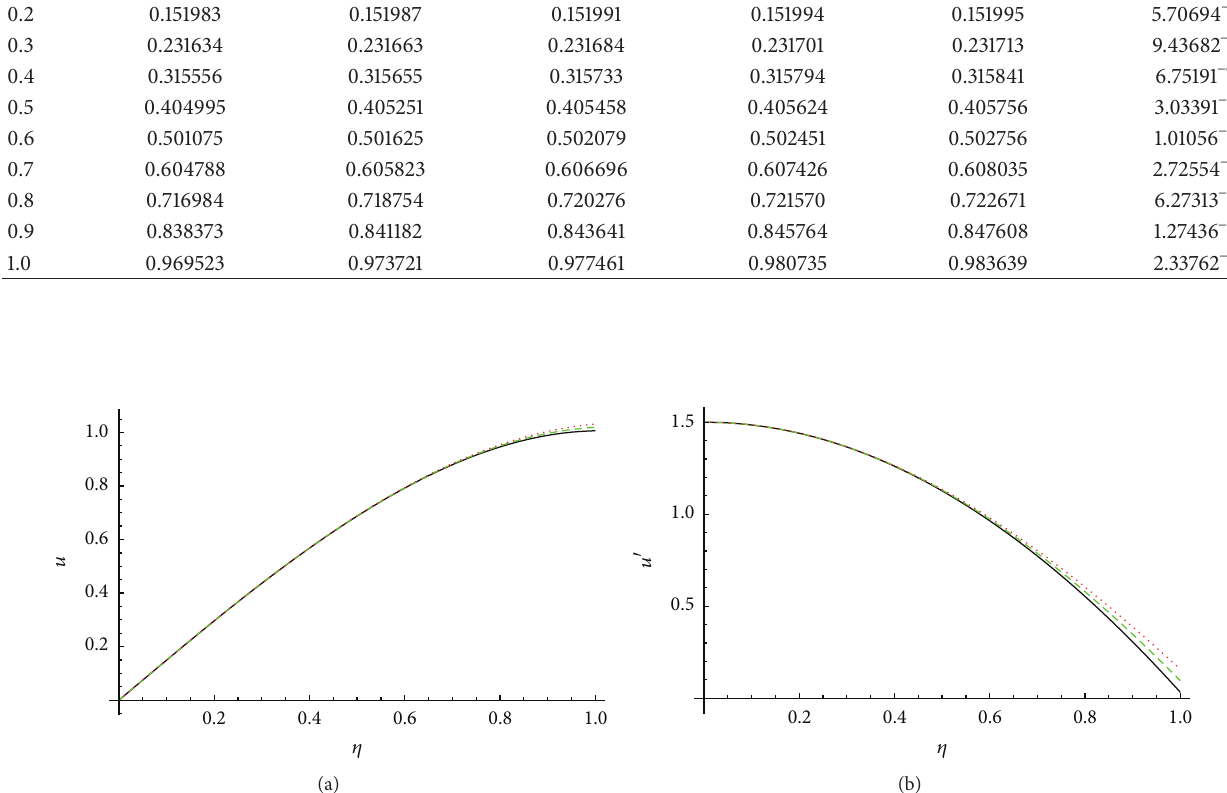
Figure 5: (a) Velocity profiles (normal velocity) for 𝑅 = 0.1 (continuous curve), 0.3 (dashed curve), and 0.5 (dotted curve) at 𝛼 = 4.0 in case of no-slip boundary. (b) Velocity profiles (longitudinal velocity) for 𝑅 = 0.1 (continuous curve), 0.3 (dashed curve), and 0.5 (dotted curve) at 𝛼 = 4.0 in case of no-slip